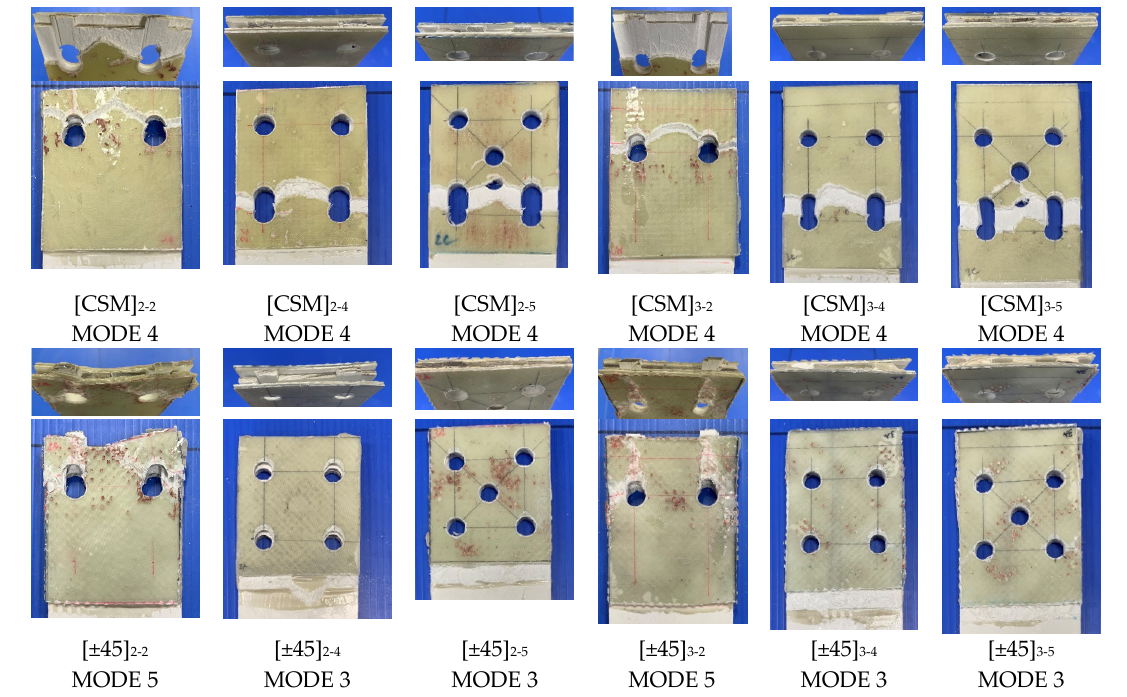
Figure 7. Typical failure modes of the PGFRP connections in the experiment. The failure modes were combined from two or three elements’ details, as shown in Table 4. Table 4. Detail of failure mode in